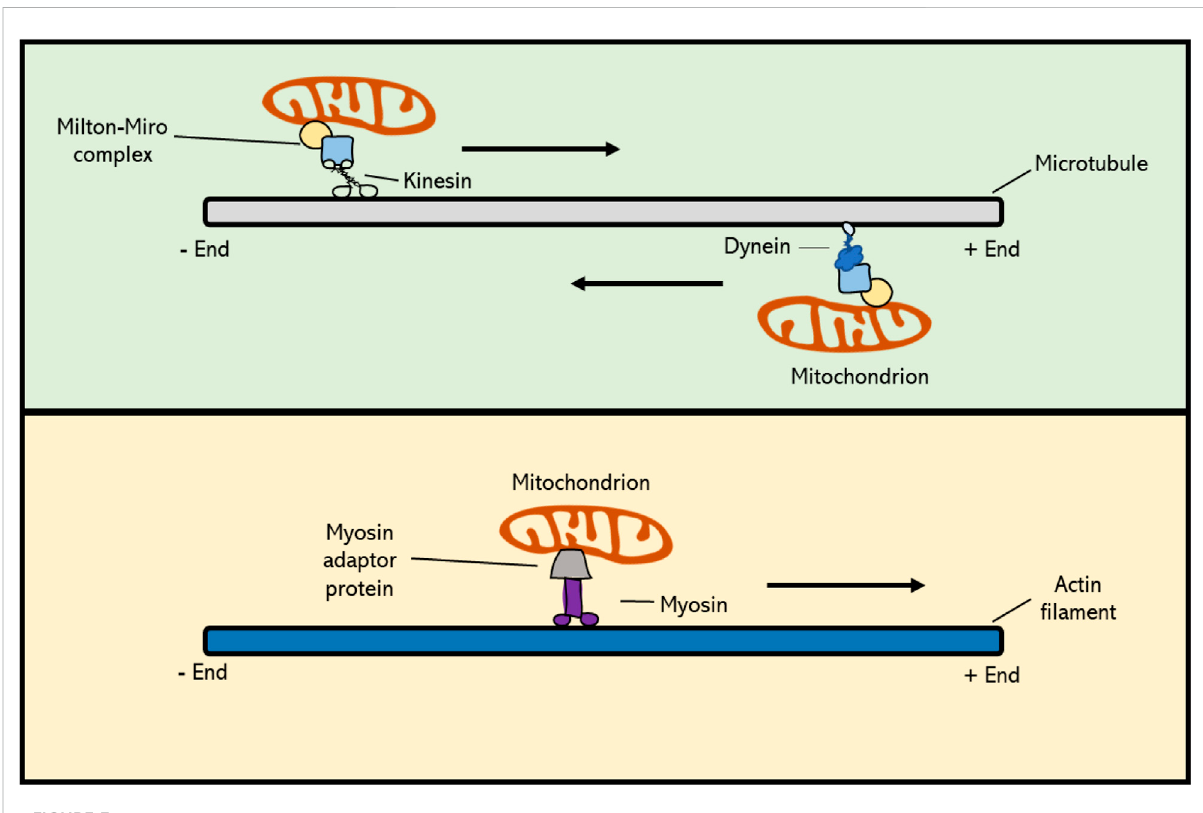
FIGURE 3 Cytoskeleton-based transport of mitochondria occurs via molecular motor proteins. Kinesin family proteins mediate cargo transport towards the plus-end of the MT polymer, whereas dyneins actively move toward the minus-end. In plant cells, MT-based movement of intracellular components ismediatedbykinesins,as higher plants donotpossessdyneins.MitochondrialRhoGTPase proteins(Miro) formacomplexwith Milton adaptor proteins to facilitate the binding of mitochondria to motor proteins. Myosin motor proteins facilitate transport of cargo along the actin cytoskeleton, and this occurs via a potential, yet unknown, actin-speci fi c adaptor protein. Myosins generally move towards the plus-end of F-actin, with the exception of myosin class VI, which moves towards the